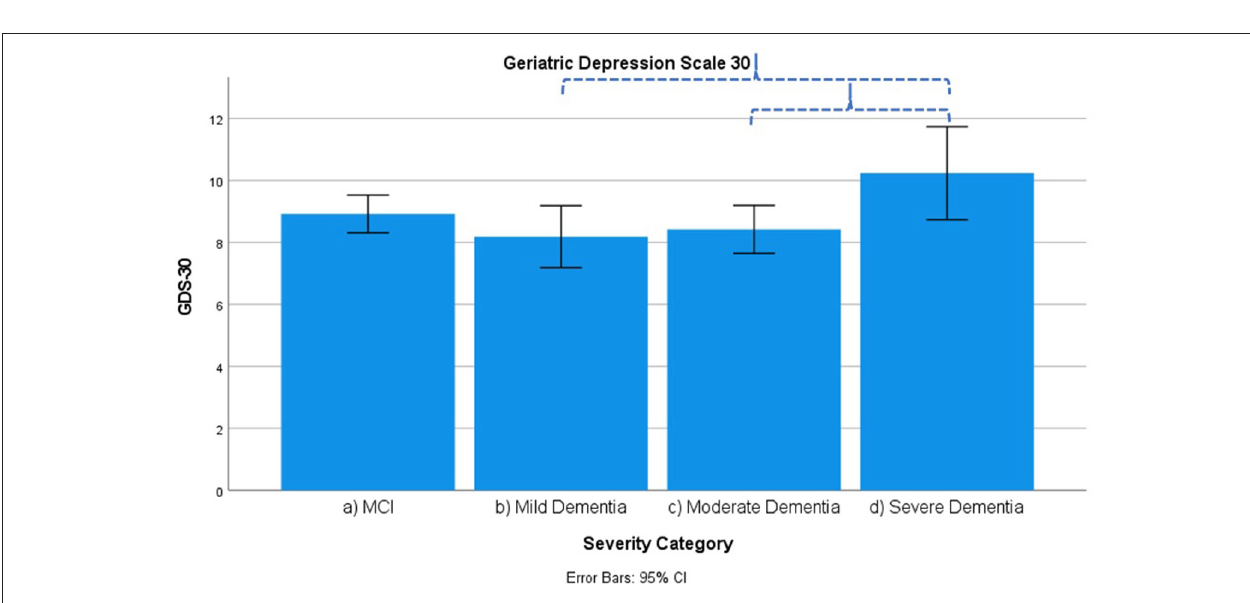
FIGURE 7 | Mean score on the 30 item Geriatric Depression Scale (GDS-30) according to severity of cognitive impairment. Error bars are 95% confidence interval. Dotted curly brackets indicate p <